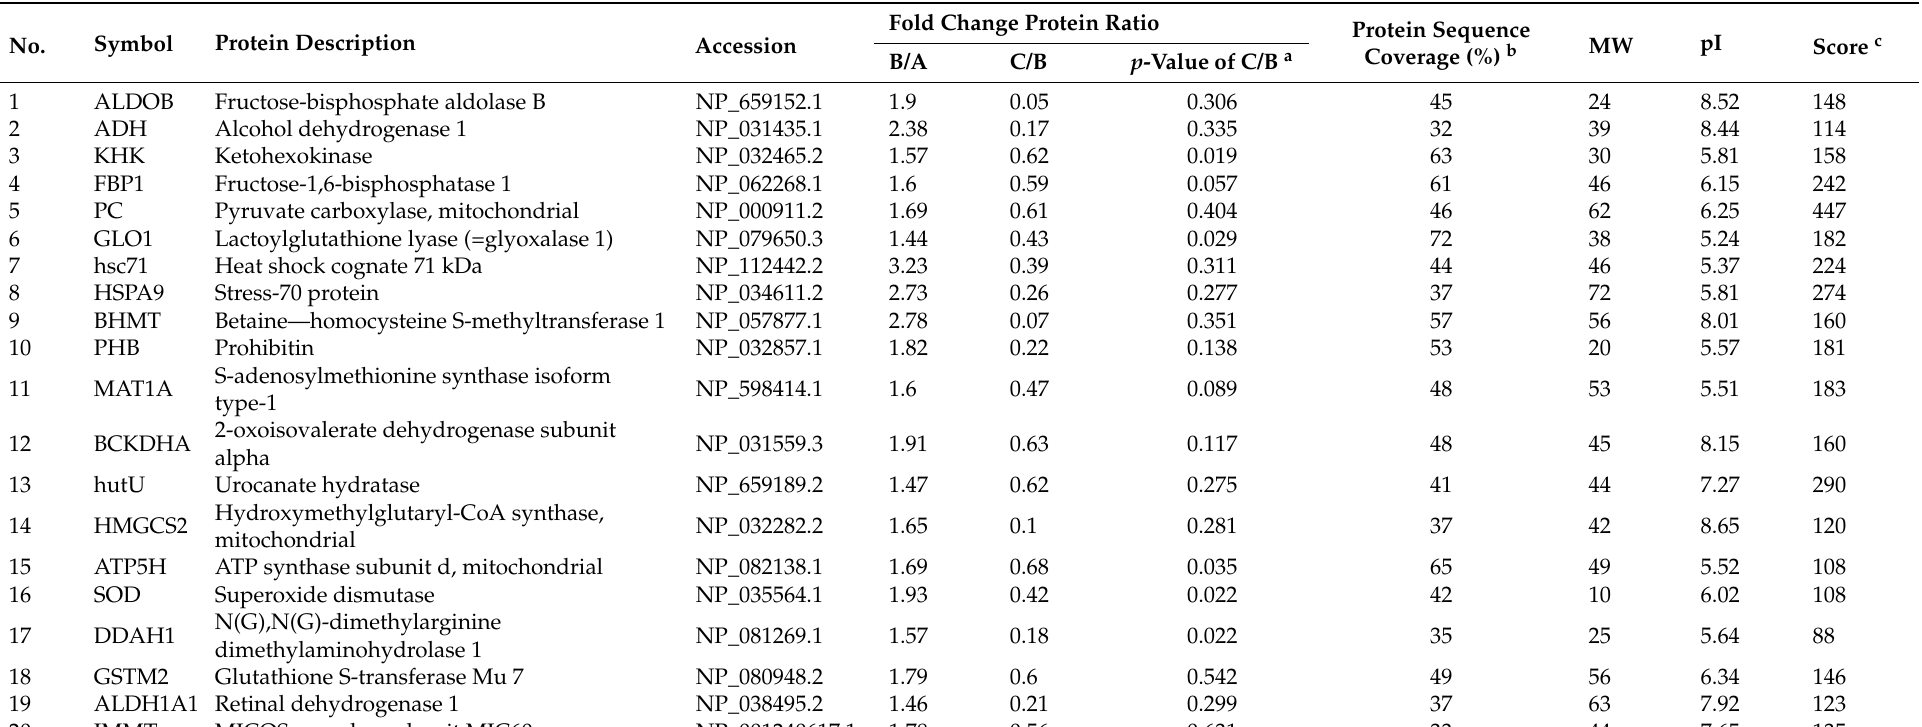
Table 1. Effect of TMP on the proteins up-regulated by the high-fat